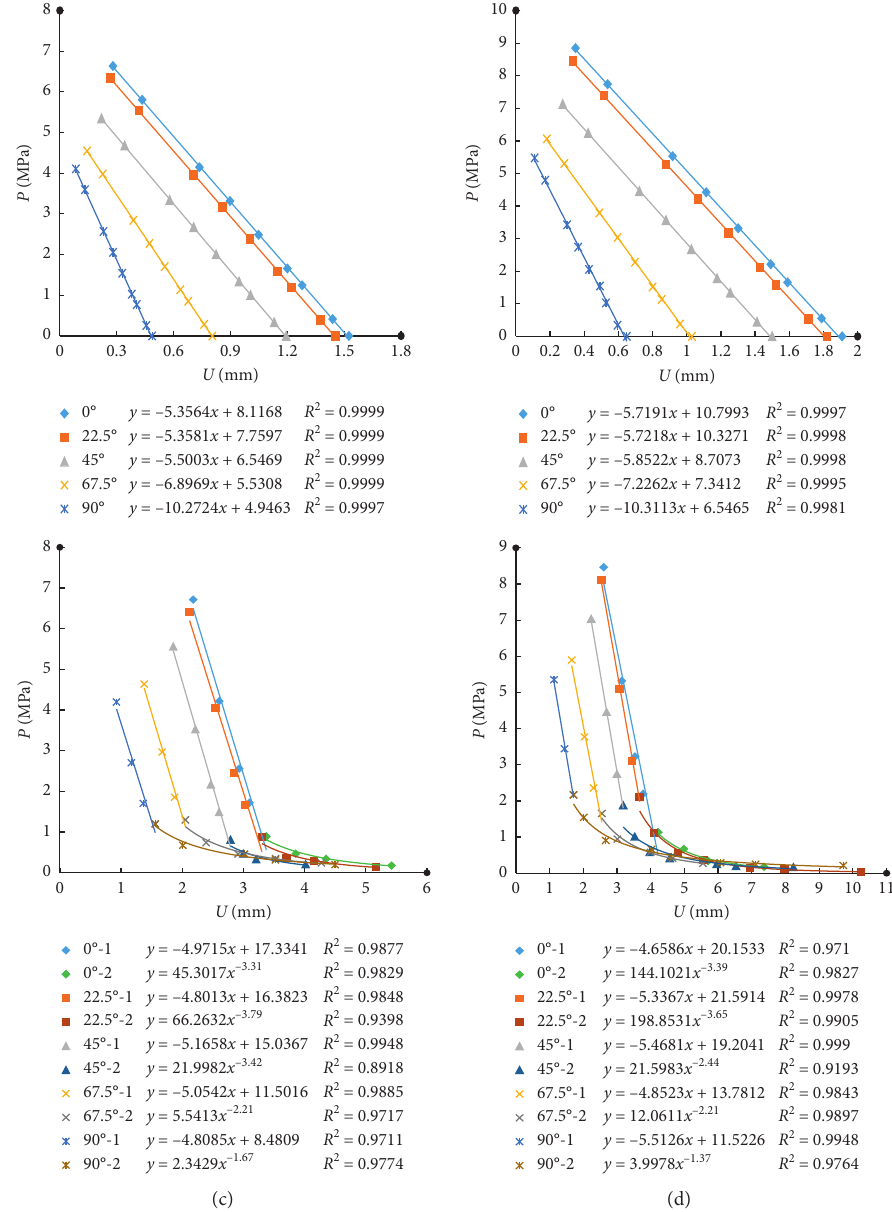
Figure 11: Best-fitting CCCs at different depths: (a) section 1; (b) section 2; (c) section 3; (d) section 4. The upper image shows the results when the BDZ is ignored, whereas the lower image represents results from models that explicitly include the